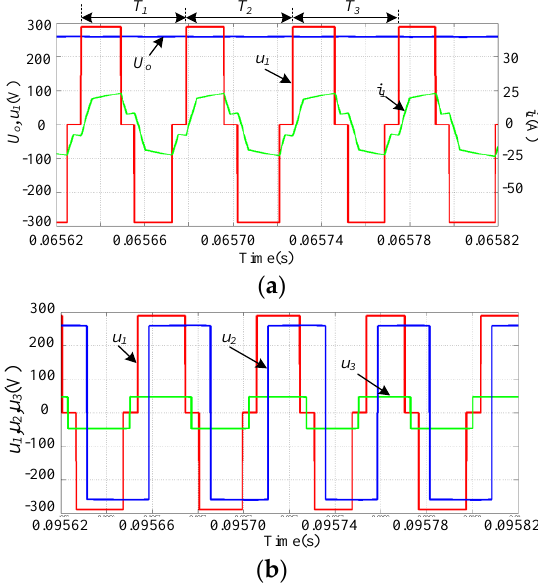
Figure 19. Simulated waveforms of phase-shifted PWM control with continuously chaotic modulation: ( a ) converter voltage, current of port 1 and output voltage of port 2; ( b ) converter voltages of port 1, 2 and 3.